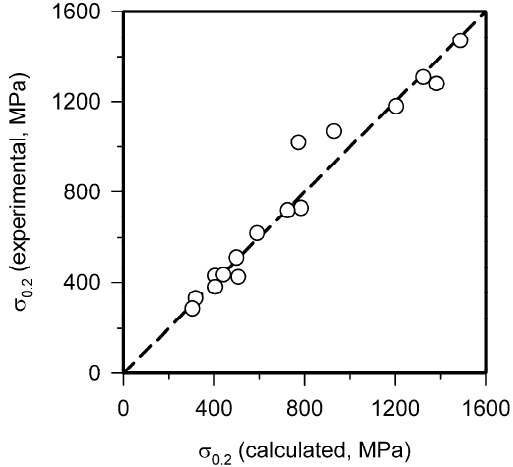
Figure 9. Relationship between the experimental yield strength and that calculated by Equation (5) for a high-Mn steel subjected to cold rolling and then annealed.